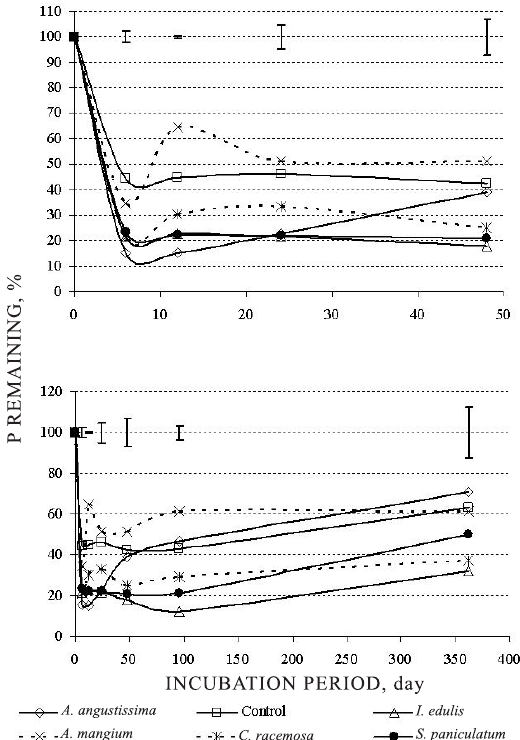
Figure 3. Percentages of P remaining in mulch from different enriched legumes trees and natural fellow as control, for 48 and 362 days of incubation period. Bars represent LSD with p < 0.05.